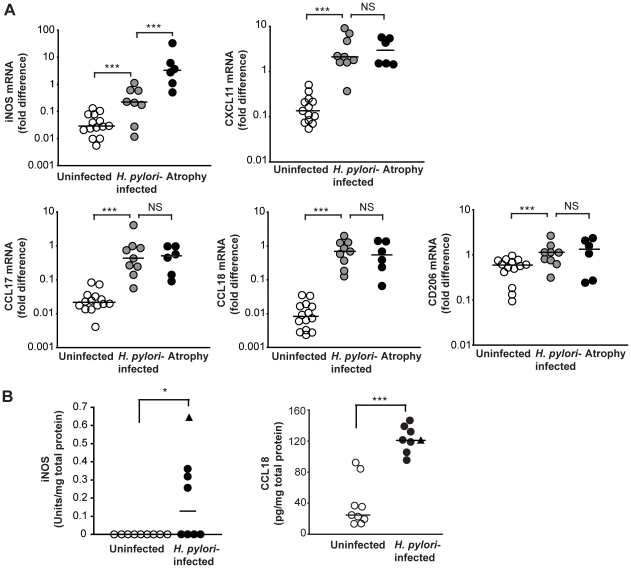
Increased M1 macrophage polarization in human atrophic gastritis.(A) The expression of genes associated with human M1 (iNOS, CXCL11) or M2 (CCL17, CCL18, CD206) macrophage polarization was determined in the gastric mucosa of uninfected and H. pylori-infected individuals with uncomplicated or atrophic gastritis by real-time PCR. Symbols represent individual values and horizontal bars indicate the medians. (B) Concentration of CCL18 and iNOS in protein extracts of gastric biopsy specimens from uninfected and H. pylori-infected individuals. Filled circles represent individuals with uncomplicated H. pylori-associated gastritis and the triangle represents a single individual with atrophic gastritis. Horizontal bars indicate the medians. *, P<0.05 ***, P<0.001 via Mann-Whitney U test.